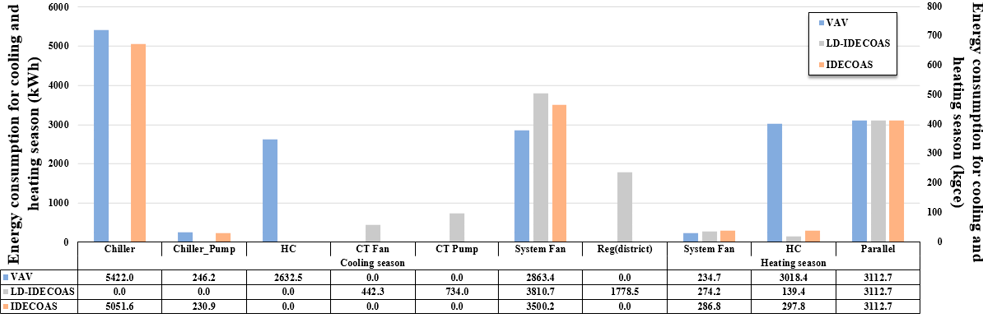
Figure 15. The seasonal energy consumption comparison in Xi’an.